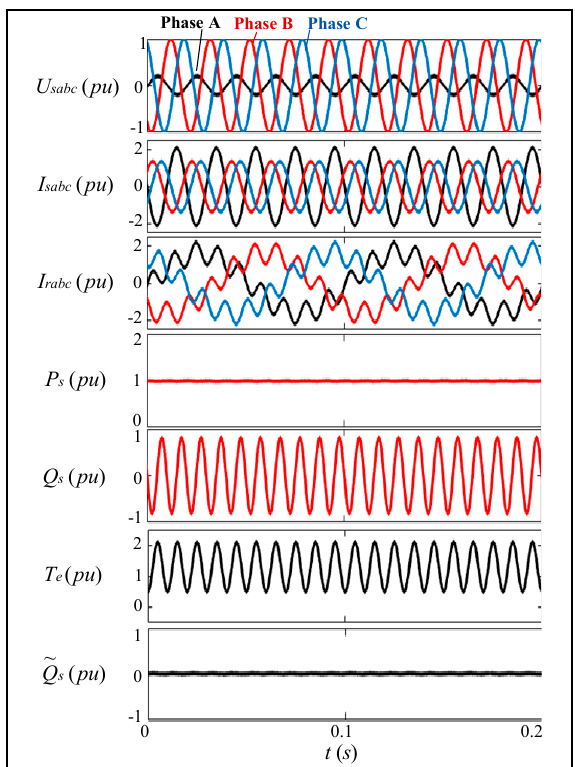
Figure 10. Conventional VSG control under a single-phase grid voltage drop of 80%.